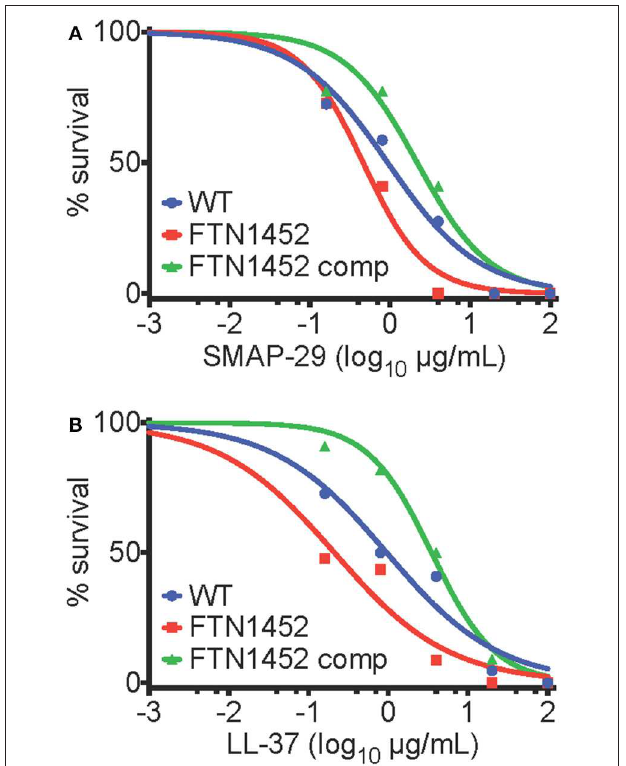
FIGURE 6 | bfpR influences AMP resistance. (A,B) Survival of bacteria with titration of cathelicidin AMPs. (A) EC 50 values of WT, bfpR, and bfpR ox with LL-37 were found to be 1.0, 0.2, and 3.5 µ g/mL, respectively. (B) EC 50 values of WT, bfpR, and bfpR ox with SMAP-29 were found to be 0.9, 0.5, and 2.2 µ g/mL, respectively. Data are shown are a representative of three independent experiments.